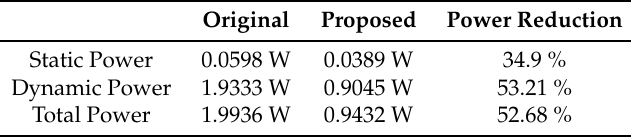
Figure 14. Power consumption comparison of the CNN accelerator on ASIC. Table 3. Power consumption comparison of the CNN accelerator on